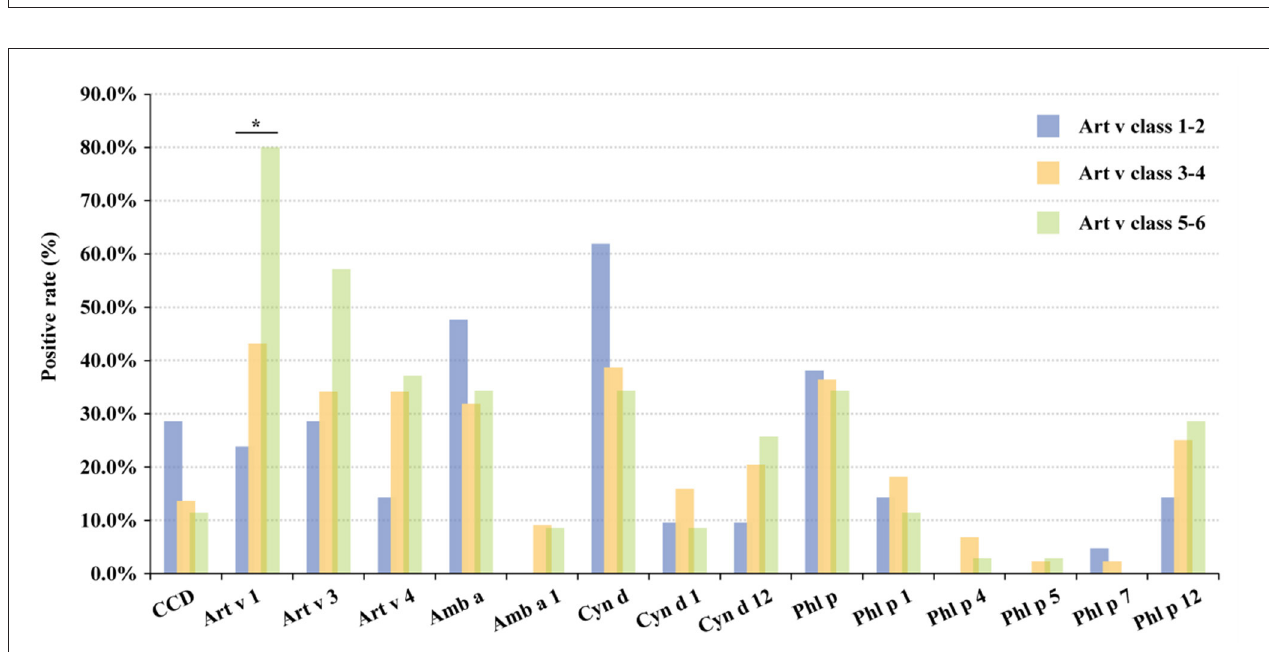
FIGURE 4 | The sIgE levels of major grass pollen allergens before and after CCD inhibition.